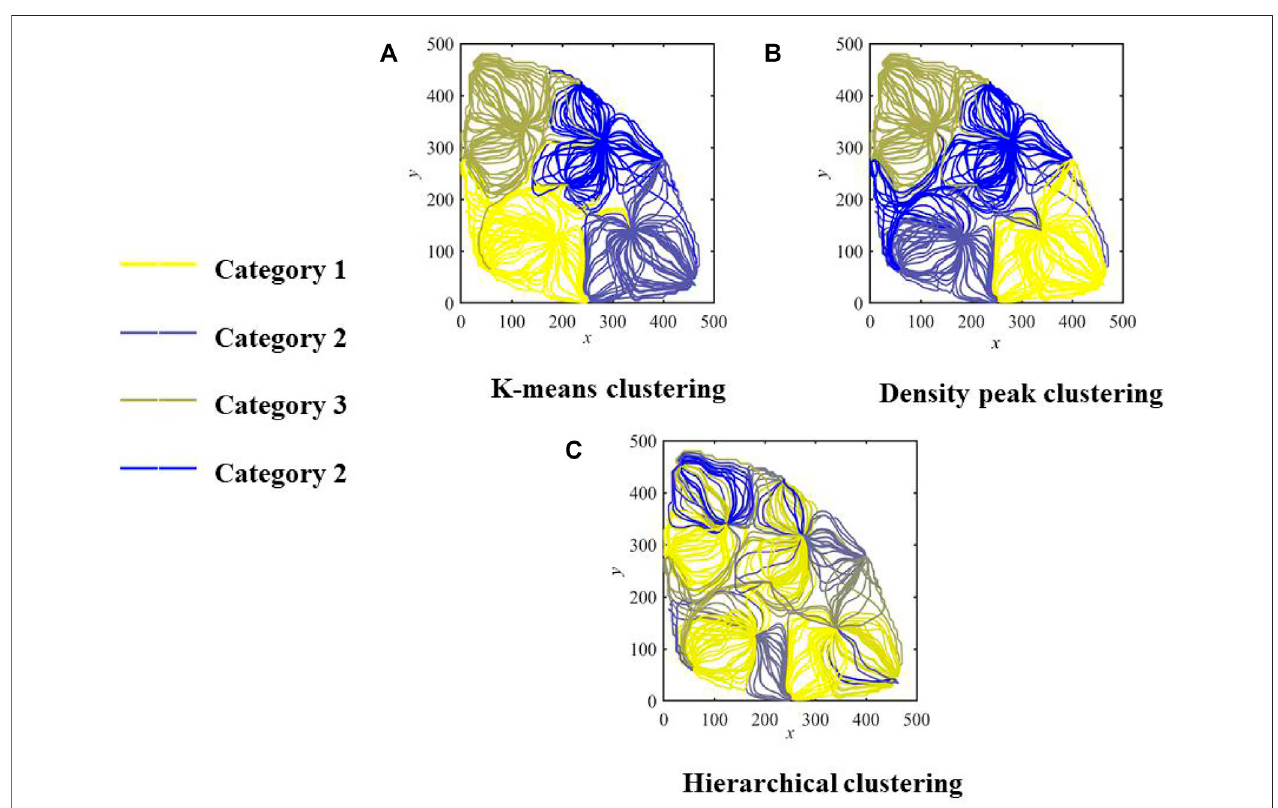
FIGURE 4 | The fl ow fi eld in clustering.